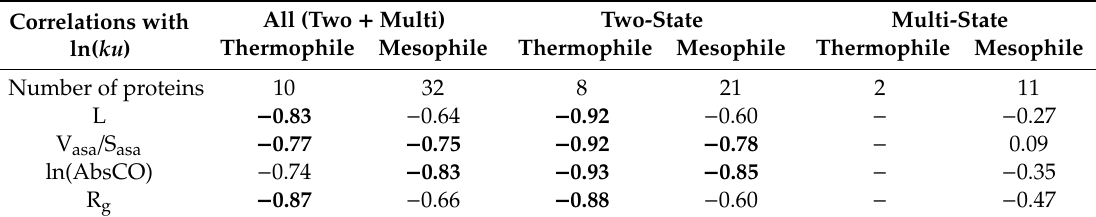
Table 8. Correlations between the logarithm of the unfolding rate (ln( ku )) and structural parameters (L, V asa / S asa , ln(AbsCO) and R g ) for two-state and multi-state thermophilic and mesophilic proteins. Correlations with